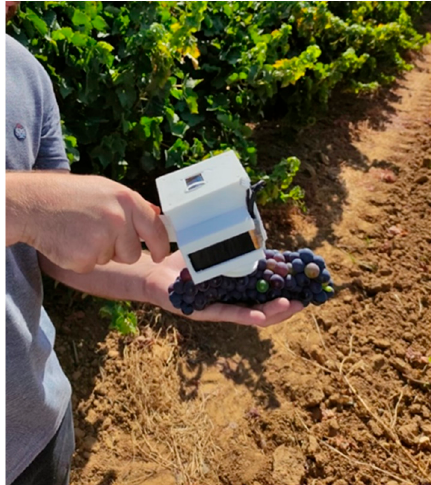
Figure 5. Methodology for spectral data acquisition.